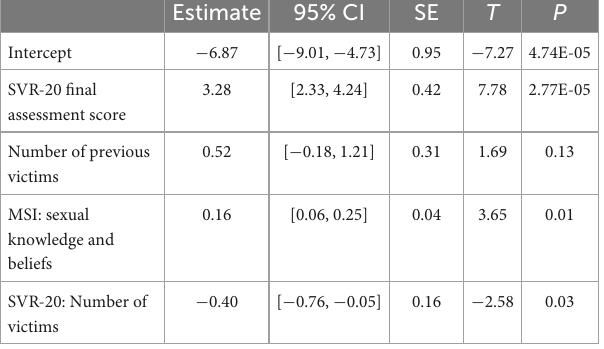
TABLE 4 Stepwise linear regression